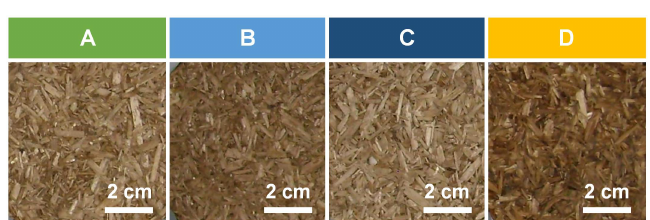
Figure 3. Surface aspect of developed